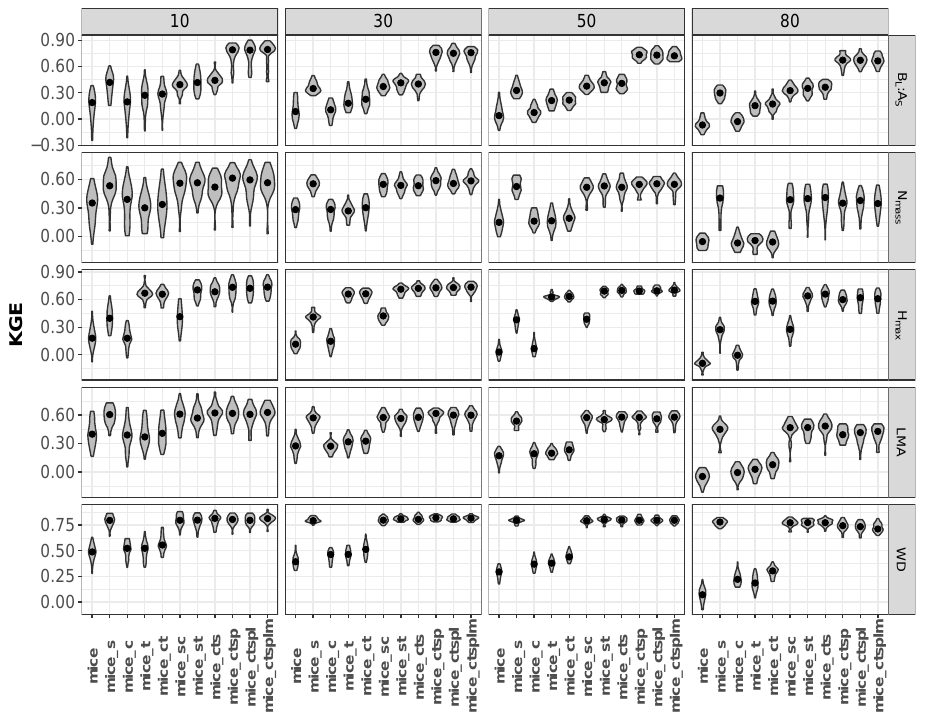
Figure 4. Trait-specific KGE at increasing missingness levels (10–80%) and for different MICE imputations using different combinations of additional predictor sets: species identity ( s ), climate ( c ), forest structure ( t ), spatial structure ( p ), lithology ( l ) and sampling month ( m ). See Fig. 1 for an overall view of the experimental design and the methods section for a detailed description of the variables employed in each predictor set. Traits: leaf biomass to sapwood area ratio, B L : A S (tm − 2 ); leaf nitrogen per unit mass, N mass (%mass); maximum tree height, H max (m); leaf mass per area, LMA (mgcm − 2 ); wood density, WD (gmcm − 3 ). Higher values of KGE imply higher